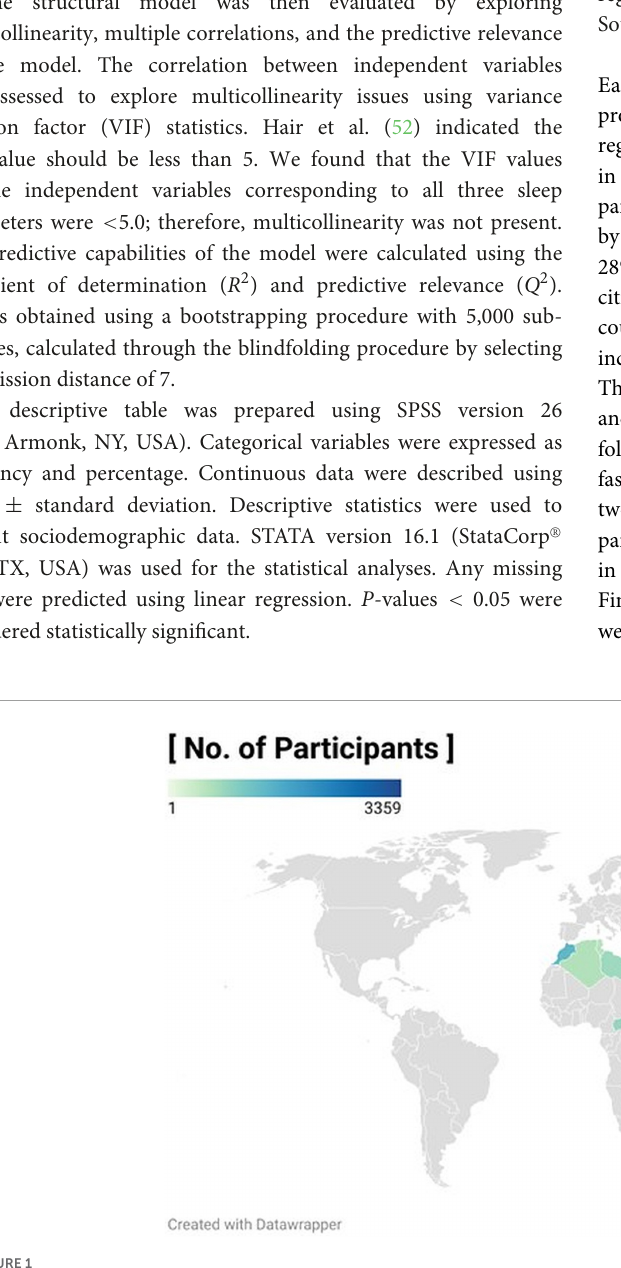
FIGURE1 Worldmap showing the number of participants using color density for the 27 participating